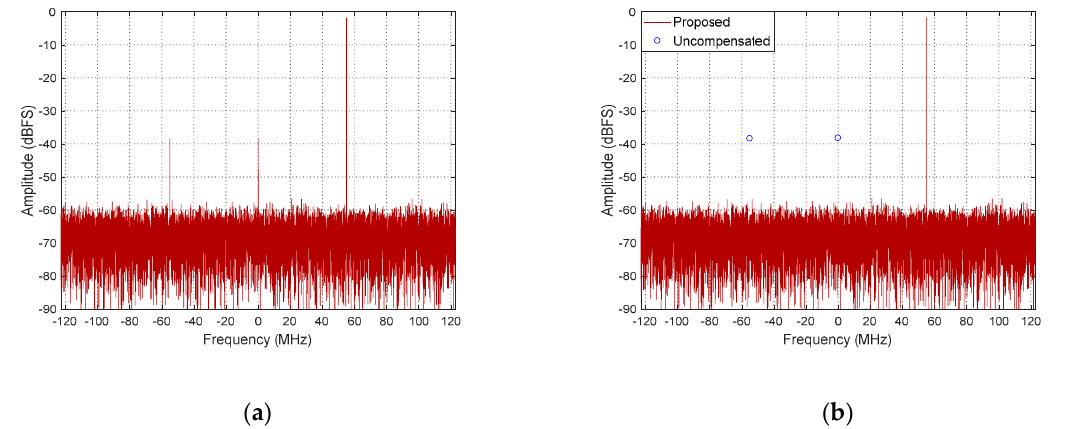
Figure 8. The amplitude spectra of single ‐ tone signal: ( a ) Before imbalance compensation; ( b ) after imbalance compensation. The number of calibration points N = 64 and the number of signal points 2N 1 = 2.